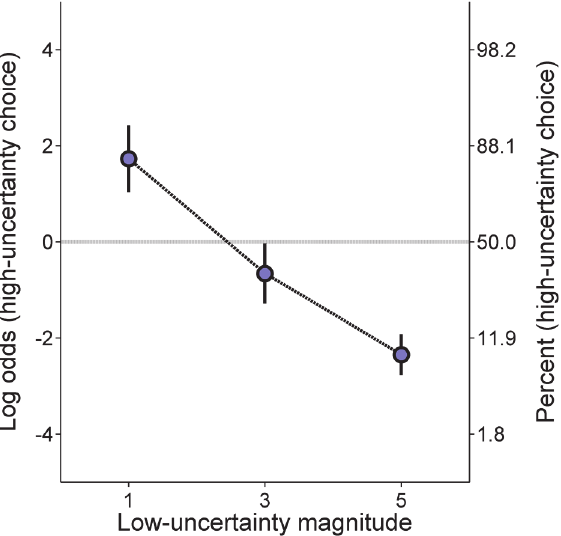
Fig 10. Mean ( ± SEM) log odds of high-uncertainty choices in the low-uncertainty magnitude training procedure of Experiment 3B as a function of the outcome magnitude of a low-uncertainty choice. A second ordinate showing percentages corresponding to the log odds values is included to aid